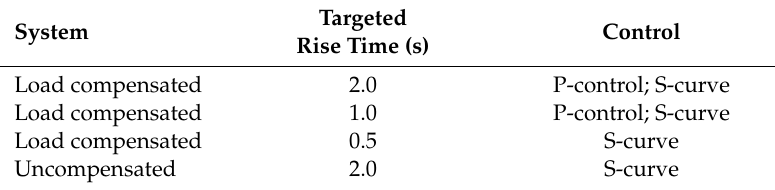
Table 2. Measurement program.